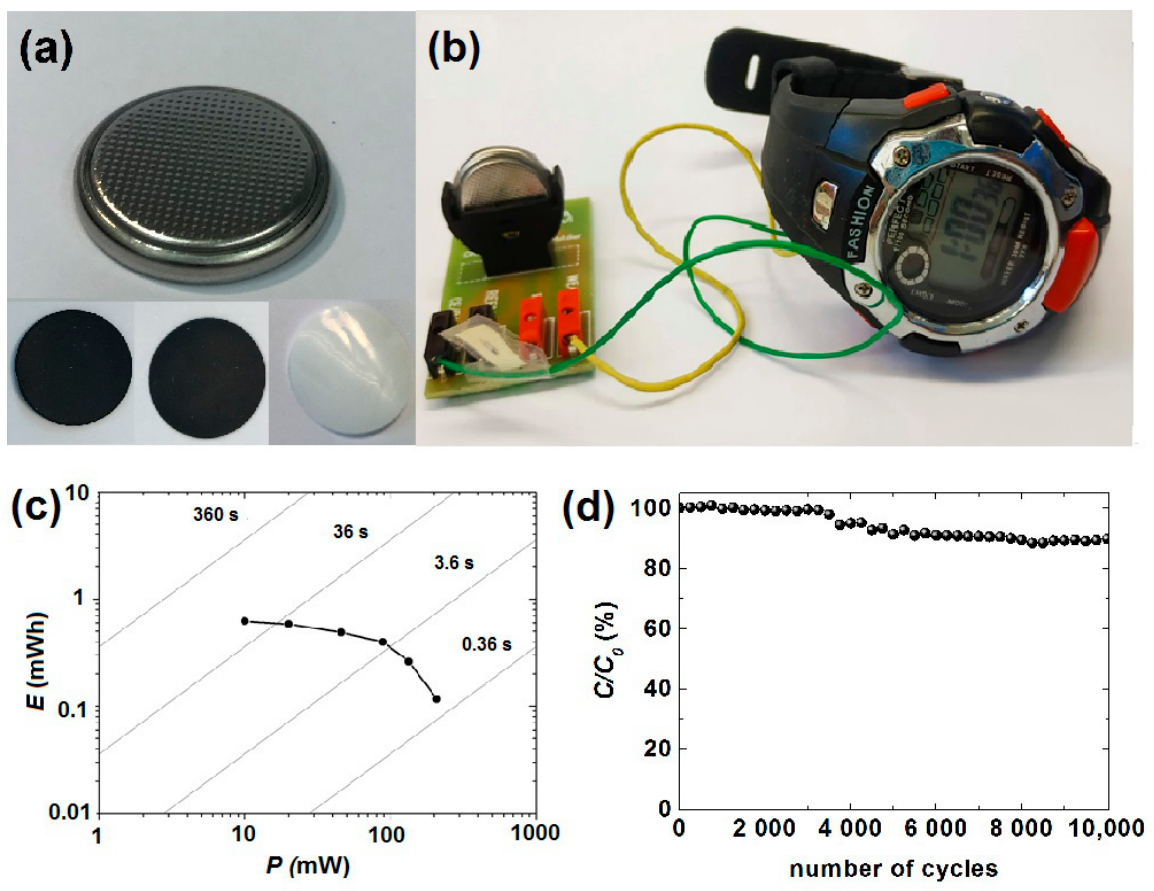
Figure 2. ( a ) AC-6/KI-CR2032 coin cell and its components, ( b ) coin cell tested: as a power supply for electronic watch, ( c ) Ragone chart derived from the constant power test, ( d ) capacitance response during 10,000 of GCPL cycles at 1 A g − 1 .